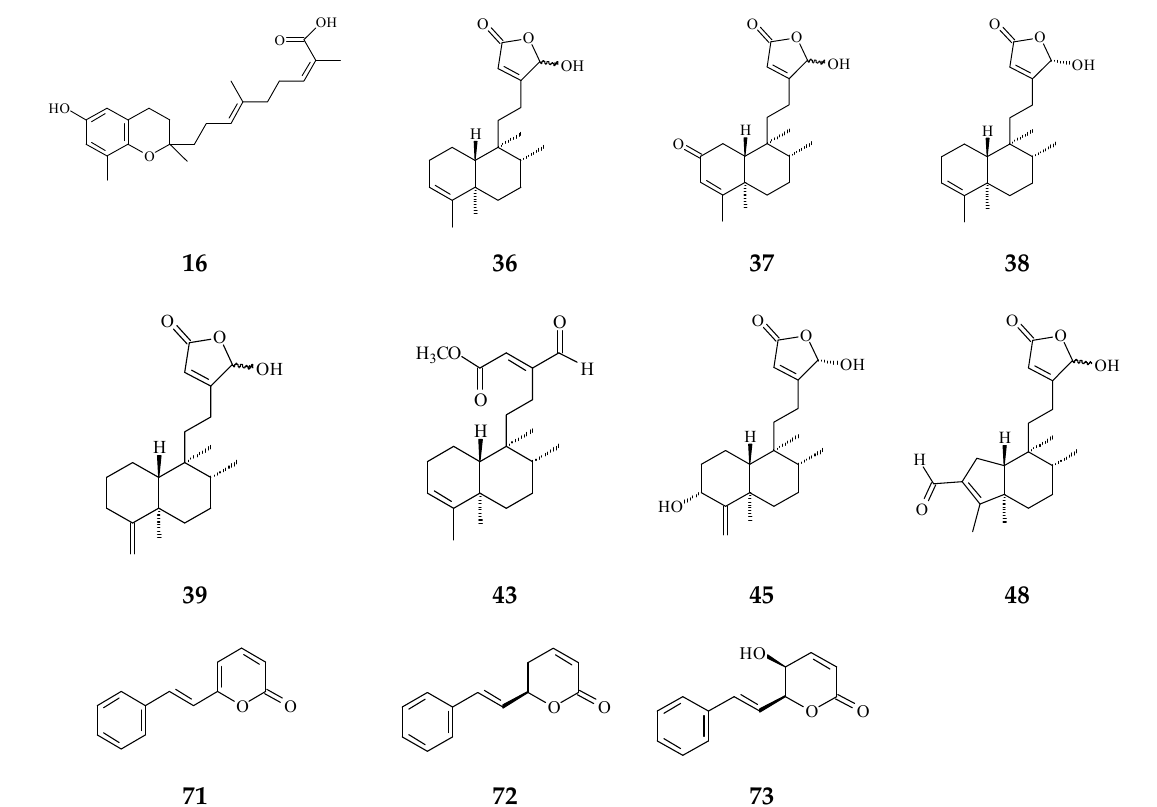
Figure 3. The phytochemical compounds isolated from species of Polyalthia with anti-inflammatory activity (16, 36–39, 43, 45, 48 and 71–73).